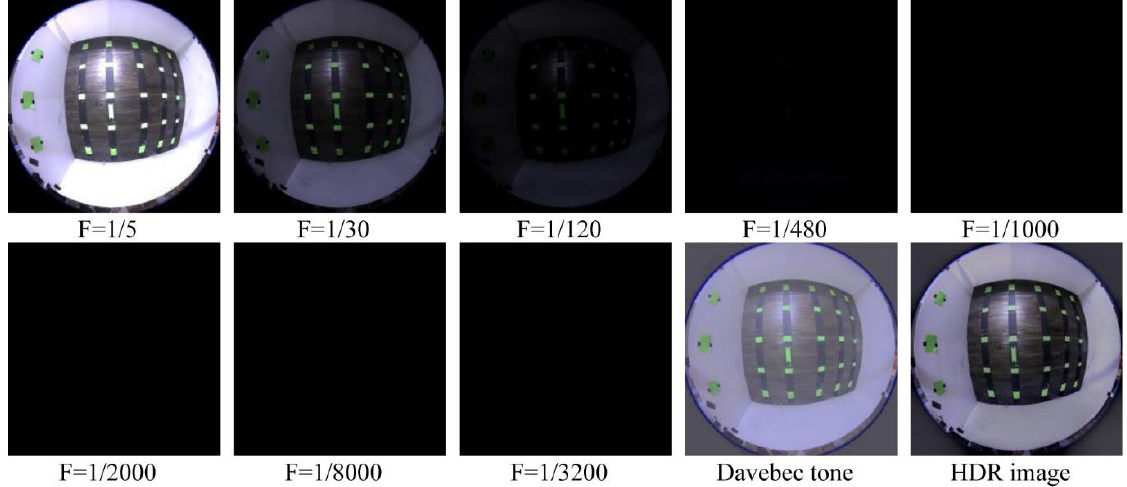
Figure 3. The images with different exposure and HDRi produced by 360° IP camera.